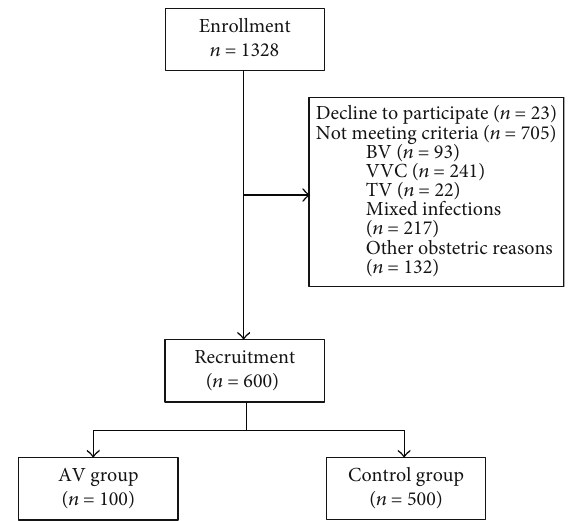
Figure 1: Patient fl ow chart. BV: bacterial vaginosis; VVC: vulvovaginal candidiasis; TV: Trichomonas vaginalis; AV: aerobic